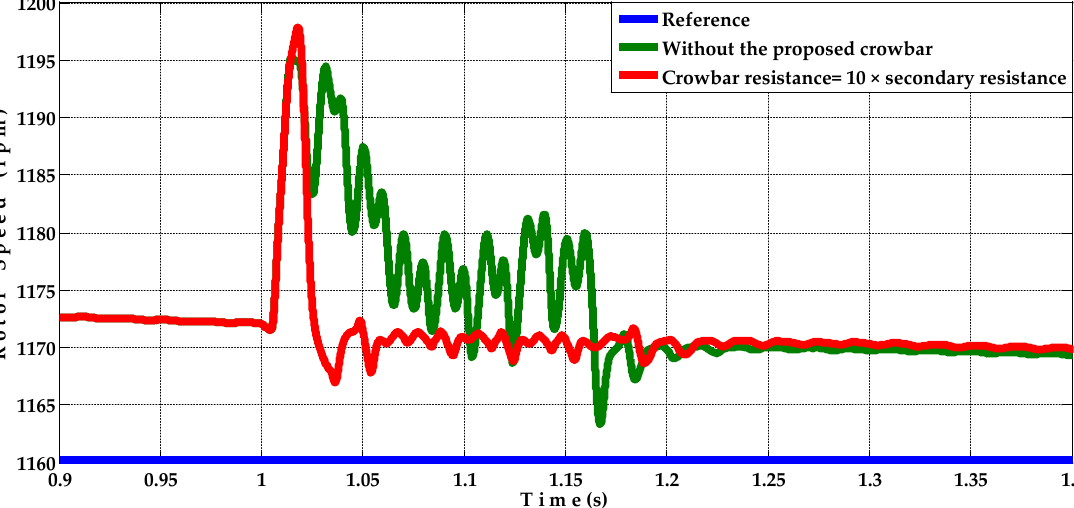
Figure 24. Rotor speed of BDFRG with and without the proposed crowbar under line to line fault occurrence.